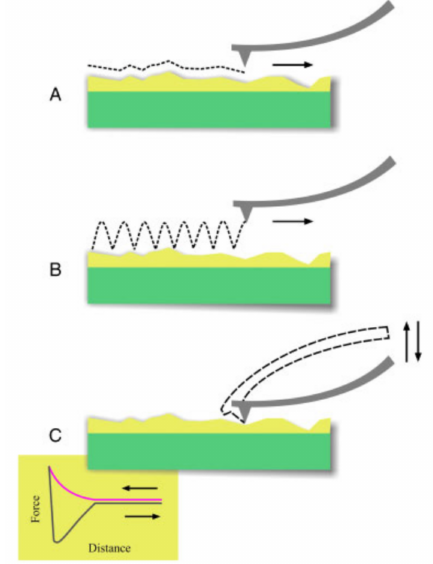
Figure 2. AFM operating modes: ( A ) contact mode; ( B ) dynamic mode for topographic imaging (the oscillation frequency in the dynamic mode is much higher than that in the scheme, i.e., the tip oscillates many times per pixel); and ( C ) force spectroscopy mode for interaction probing. Reprinted from [8], Copyright (2010), with permission from